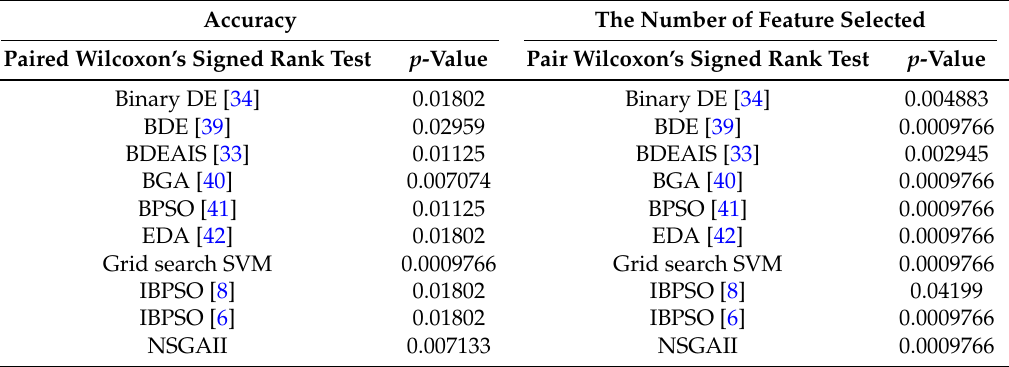
Table 14. The Wilcoxon’s signed rank test of our algorithm with other algorithms on accuracy and the number of features